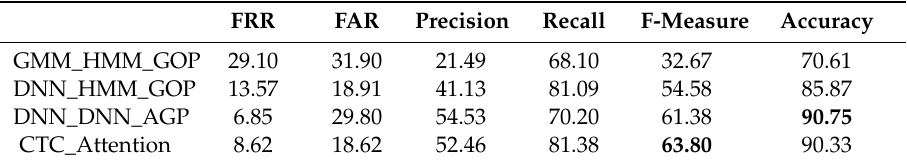
Table 13. Performance of APED systems for final a. FAR